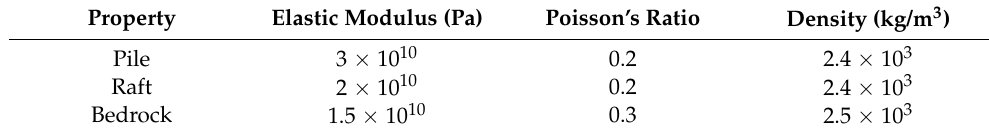
Table 2. Soil parameters of the Duncan–Chang (DC) model used in this paper